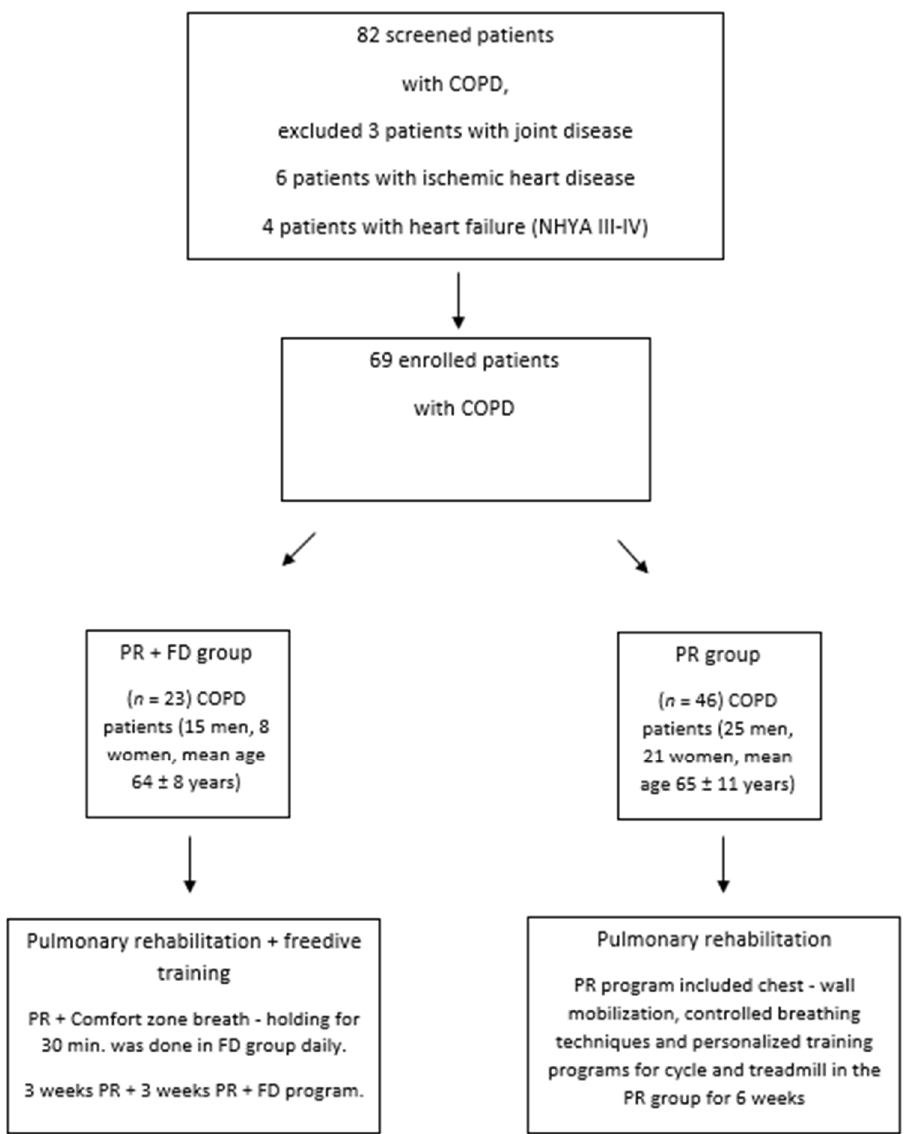
Figure 1. Algorithm of the study.